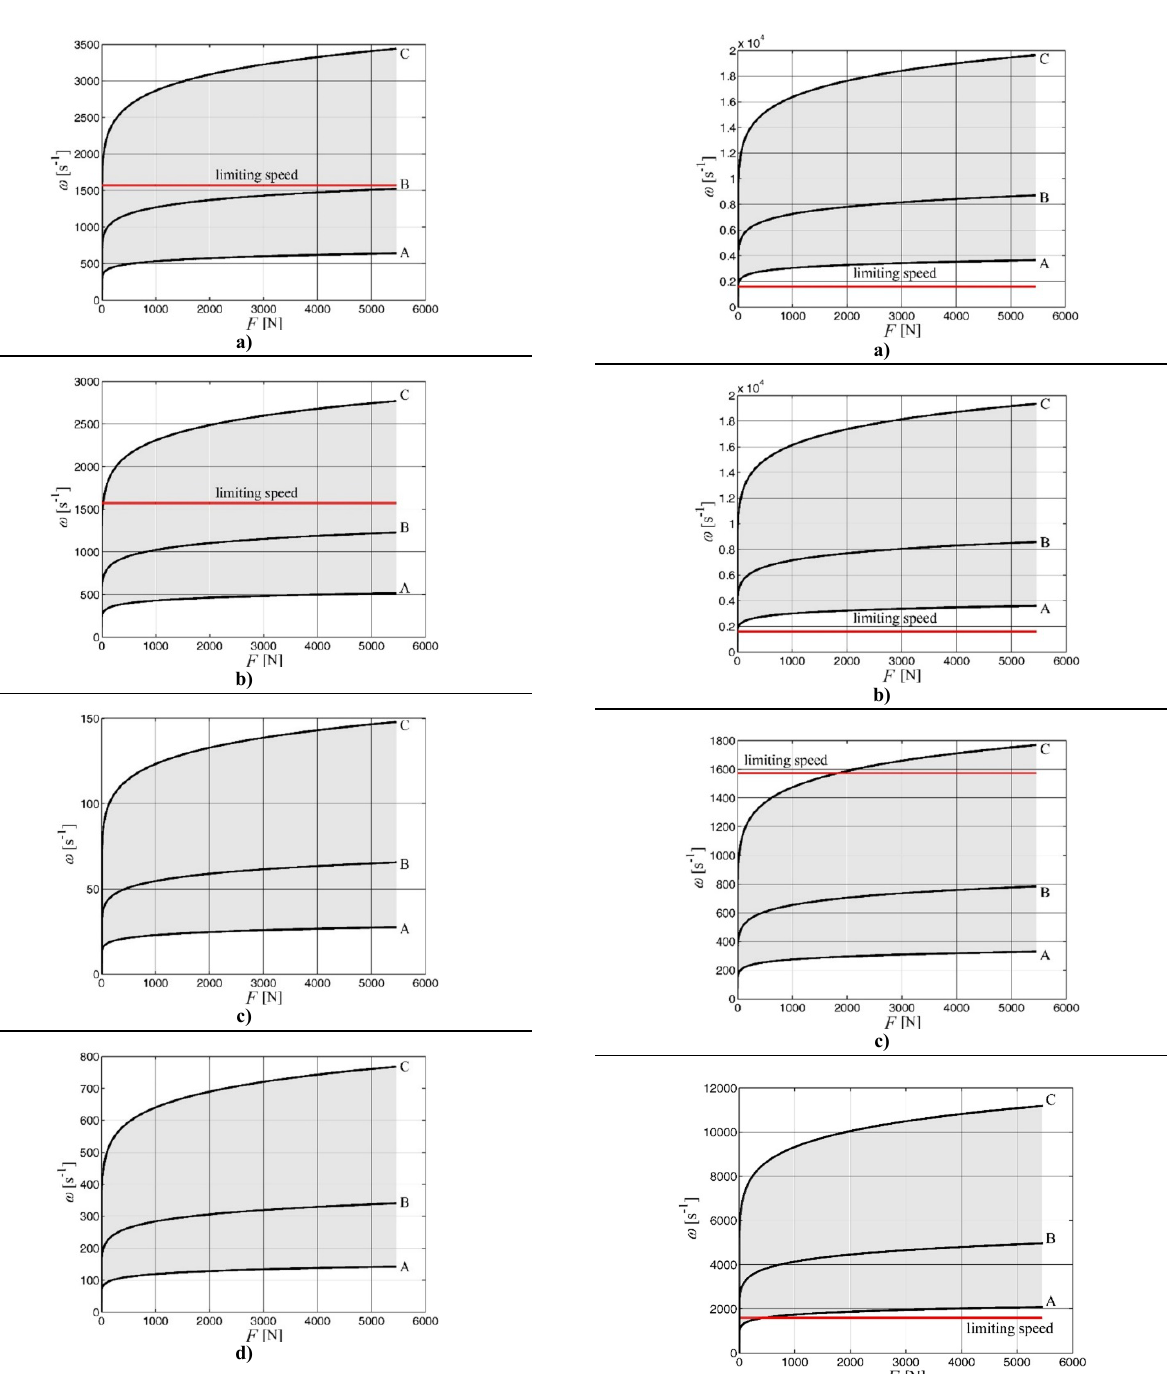
Figure 8. A plot that shows a lubrication regime dependence of angular speed ω and contact load F for rolling bearing 6206 and balls-inner raceway contact, with an operating temperature of 38°C and oil lubricant: a) Advanced Ester, b) Polyalkyl Aromatic, c) Synthetic Paraffinic Oil, d) Super-Refined Naphthenic Mineral Oil